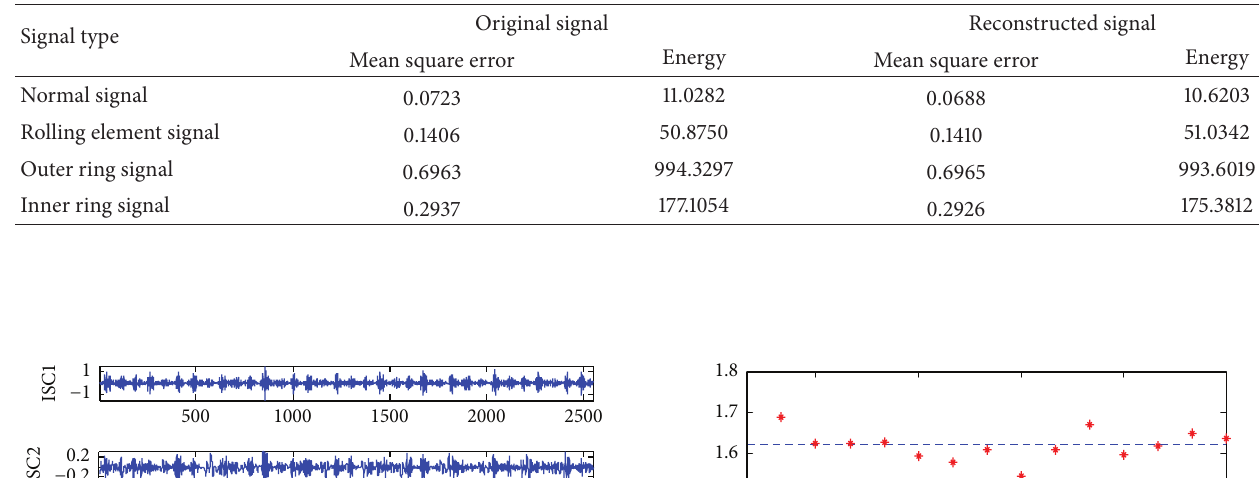
Table 1: The mean square error and energy of the original signal and the reconstructed signal.